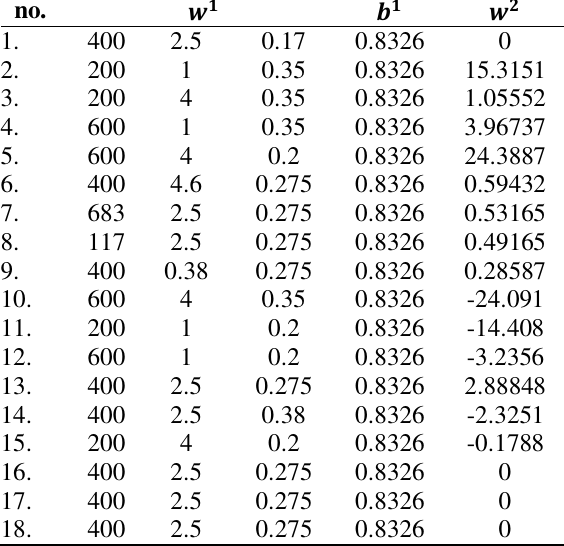
The network weights matrices and bias. )*+